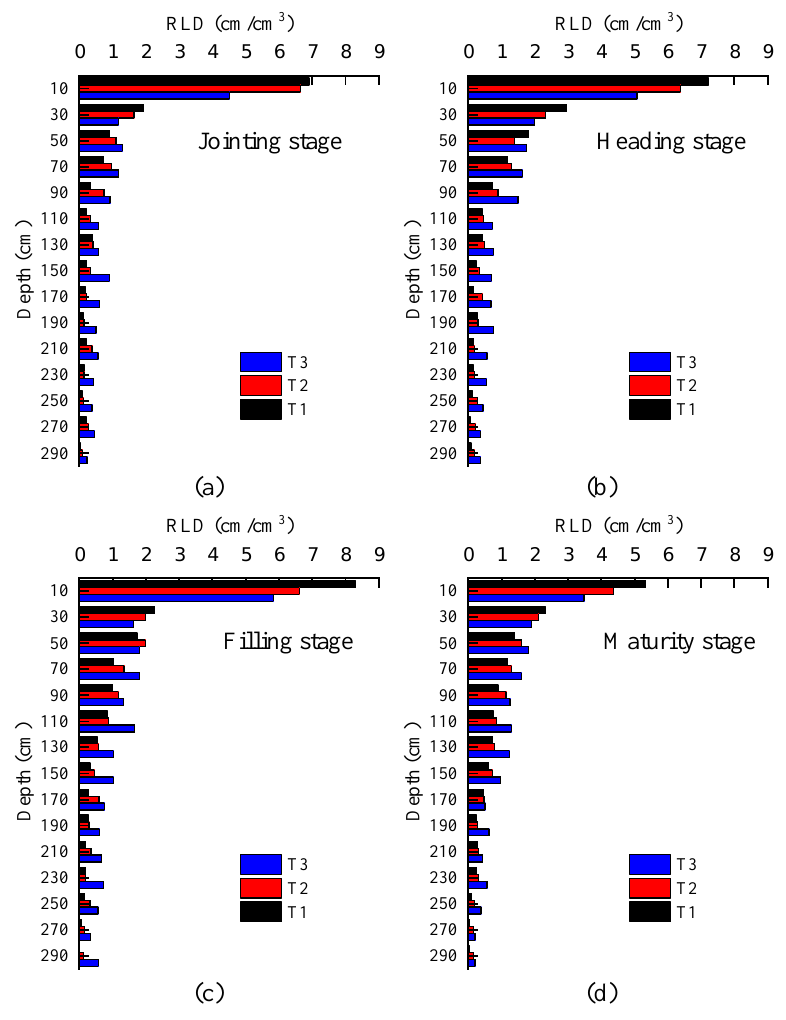
Figure 2. The distributions of the RLD of winter wheat. ( a ) Jointing stage; ( b ) Heading stage; ( c ) Filling stage; ( d ) Maturity stage.